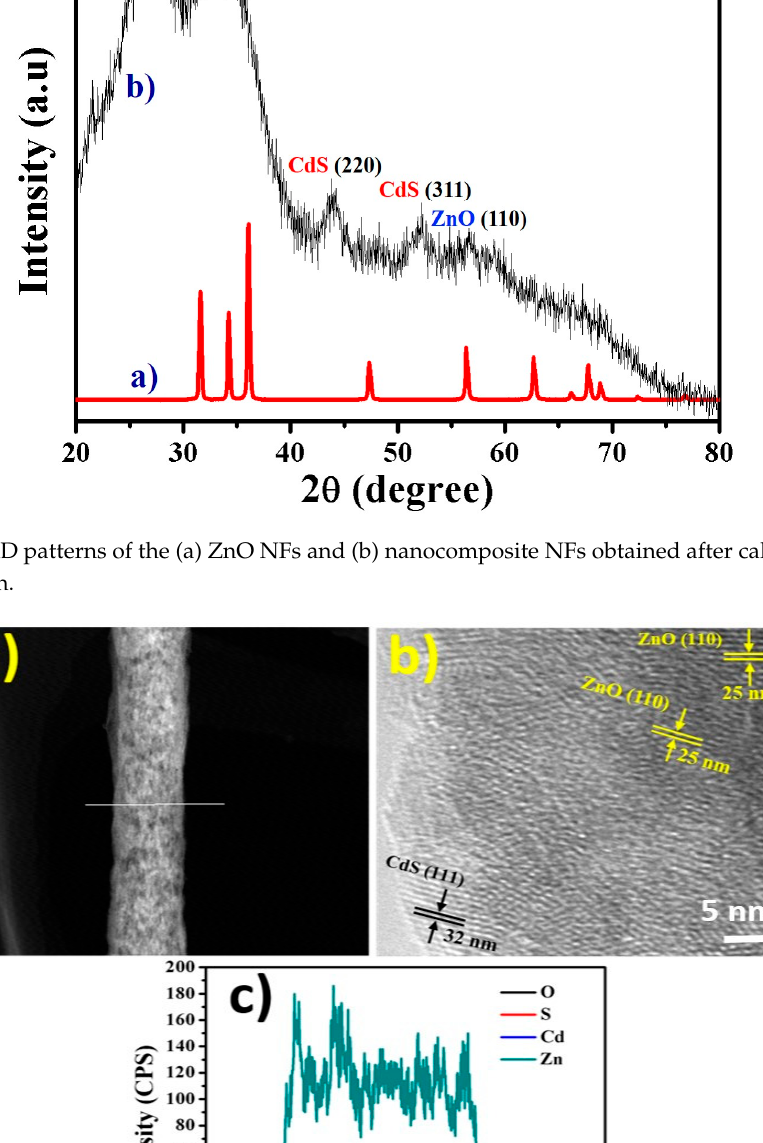
Figure 2. EDX spectrum of the prepared powder after calcination at 200 °C for 1 h.